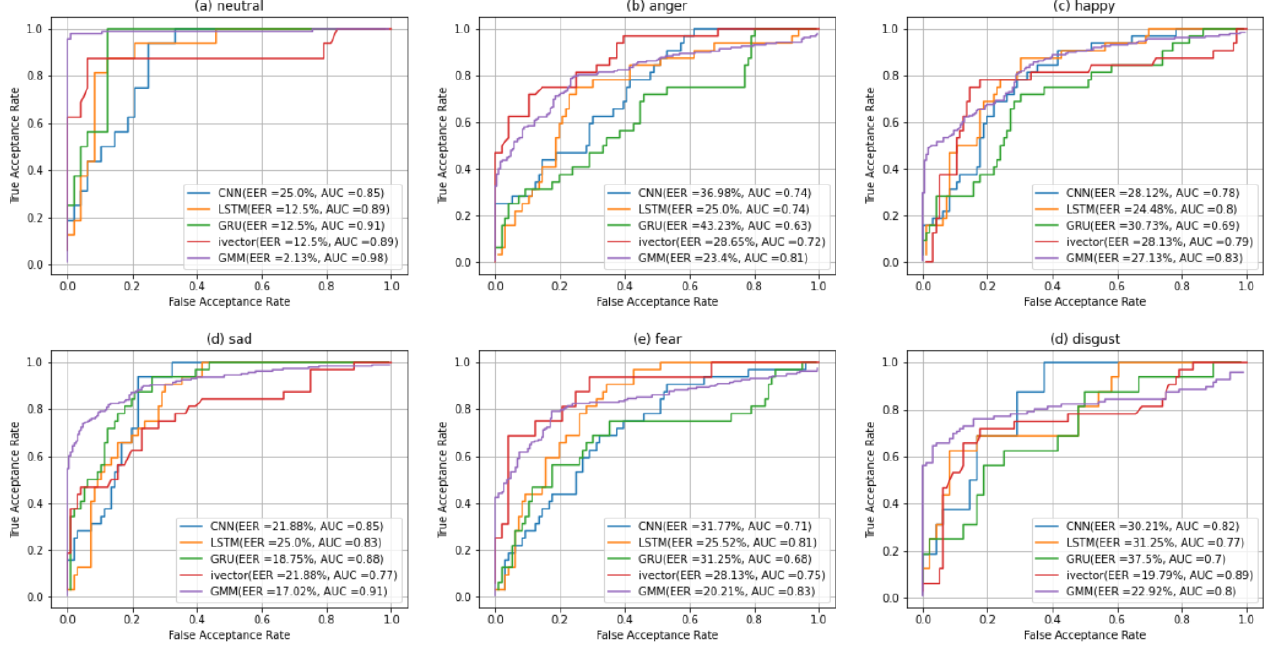
Figure 10. Plots of ROC curves for the RAVDESS database each based on the CNN, LSTM, GRU, and i vector.